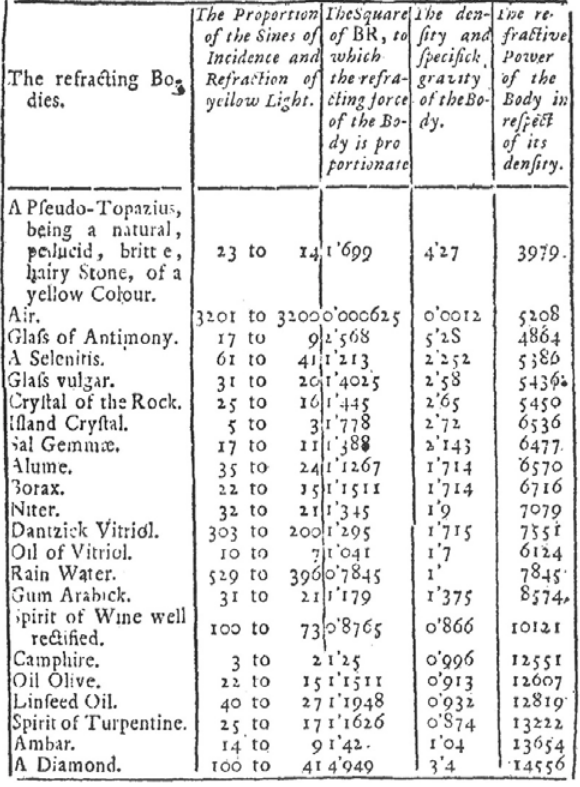
Figure 1. Newton’s measurements of the “refractive power” (col- umn 5) relating the refractive index (column 2) to the density rela- tive to water (column